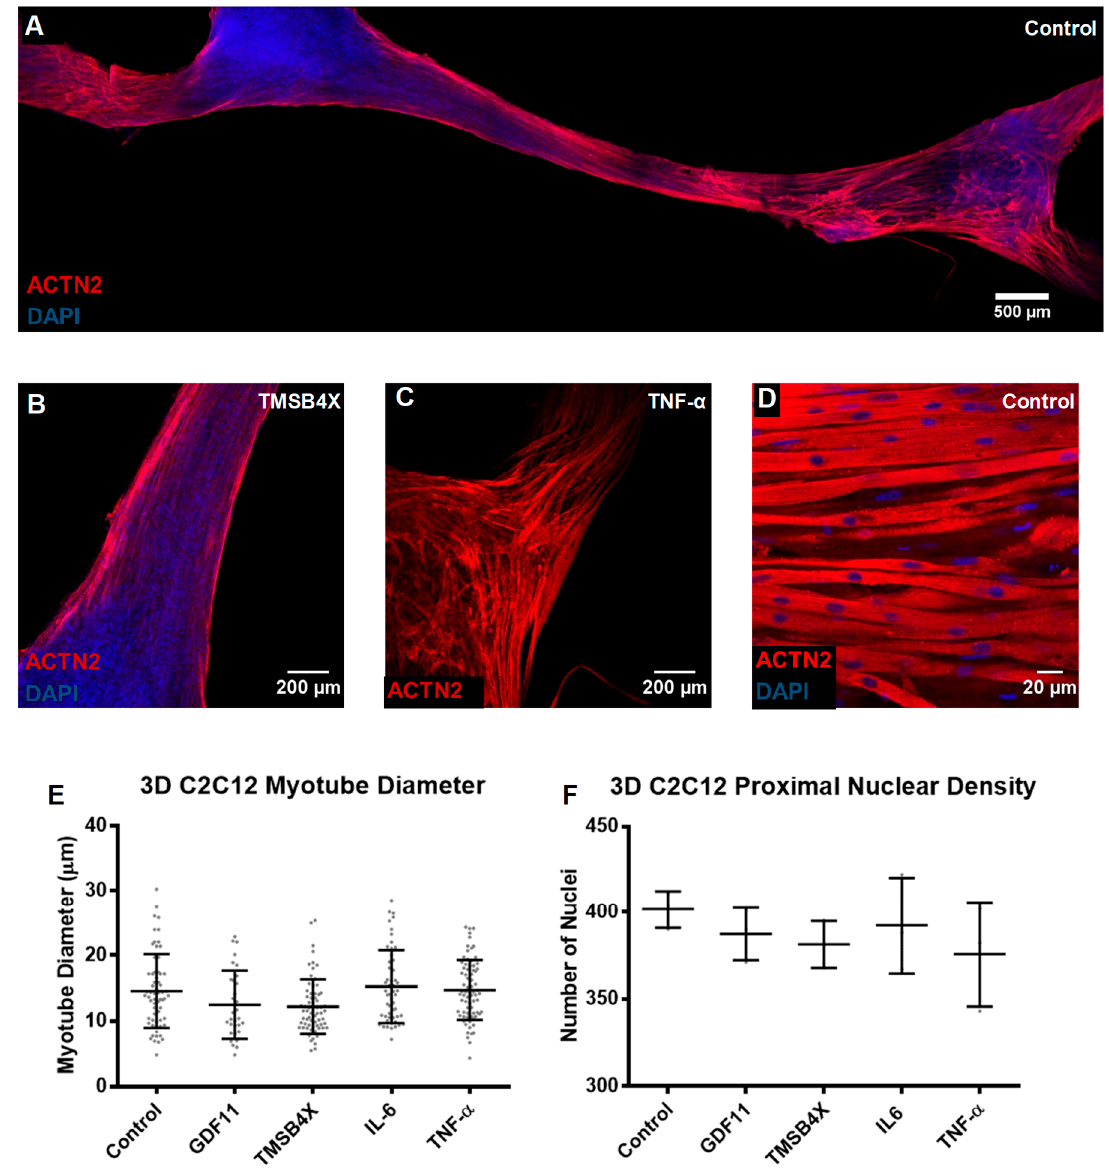
Figure 7. Skeletal muscle tissues were engineered from a composite fibrin/Matrigel hydrogel mixture with mouse skeletal myoblasts C2C12s, and subject to 10 ng/mL biological ligands. C2C12s were encapsulated and differentiated in a fibrin- based hybrid hydrogel over a 7-day period, 10 ng/mL biological ligands GDF11, TMSB4X, IL6 or TNF- α were administered after a week of tissue plating. ( A ) Immunohistochemical staining of C2C12 skeletal muscle constructs with ACTN2 and DAPI, demonstrated high cellular density. ( B ) Skeletal myotubes increased compactness and alignment towards central pillar regions where tensile force is maximal ( C ) Structural organization of C2C12s at pillar regions appeared disrupted due to gel contraction. ( D ) Cross-striated, multinucleated skeletal muscle form condensed tissues as demonstrated with high magnification 60 × confocal microscopy. ( E ) Myotube diameter ( µ m) was not affected by one-week exposure to 10 ng/mL ligands. ( n > 32, mean + SD). ( F ) Nuclear density of skeletal muscle C2C12s within tissue were not impacted with ligand administration. ( n = 6, mean +